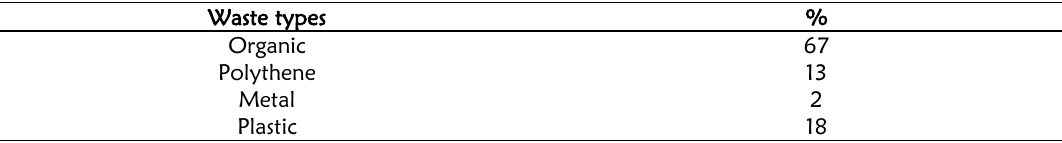
Table 10: Waste composition of Sylhet city [27]